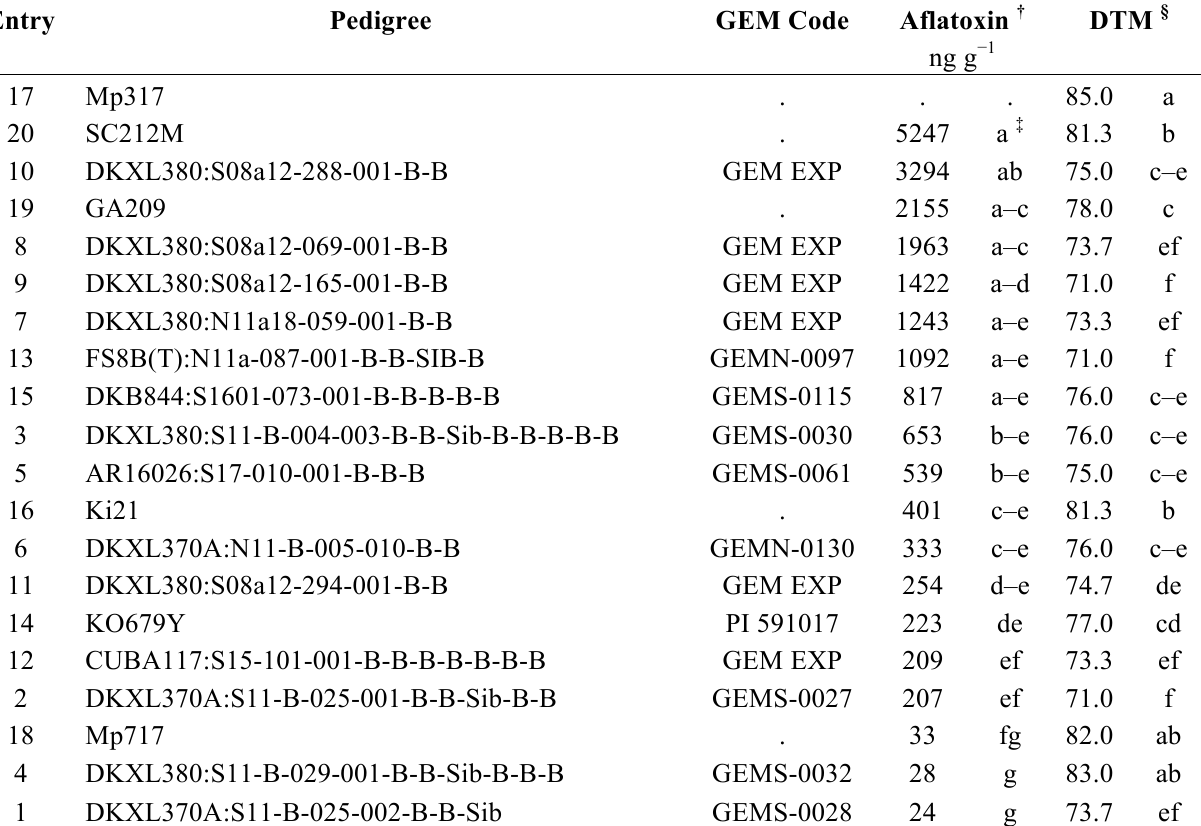
Table 2. Aflatoxin evaluation of corn inbreds in